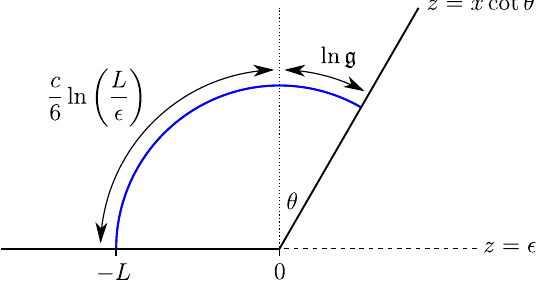
Figure 1. A constant-time slice of the geometry with an end of the world brane in Poincaré-AdS, showing the RT surface for a region x ∈ ( − L, 0) on the